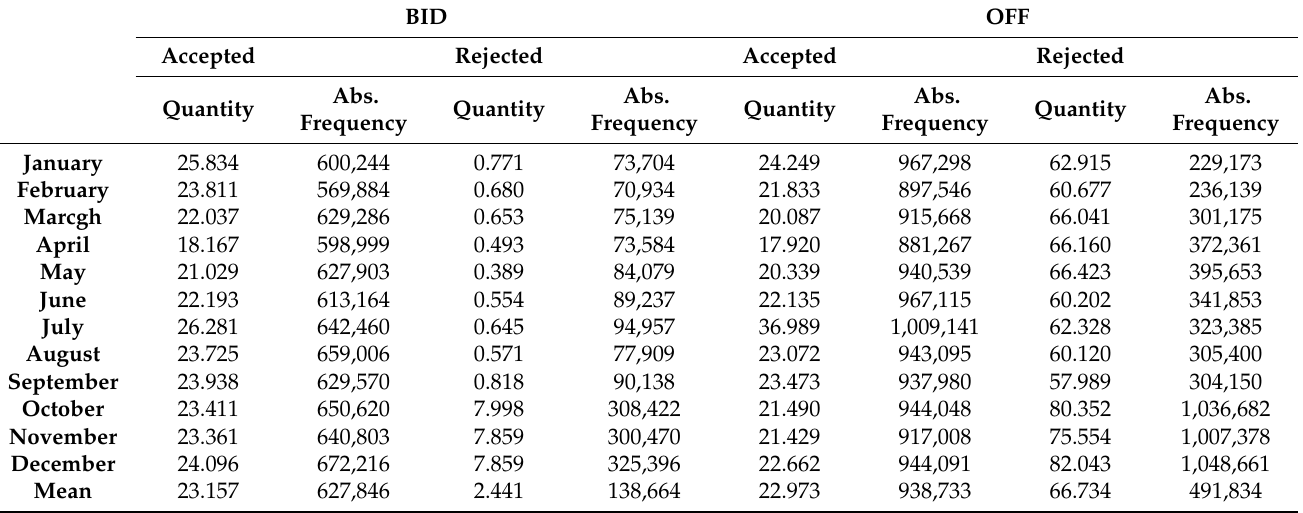
Table 2. Offer to Purchase (BID) and Sales (OFF): Monthly Total Quantity and Frequency of Accepted and Rejected